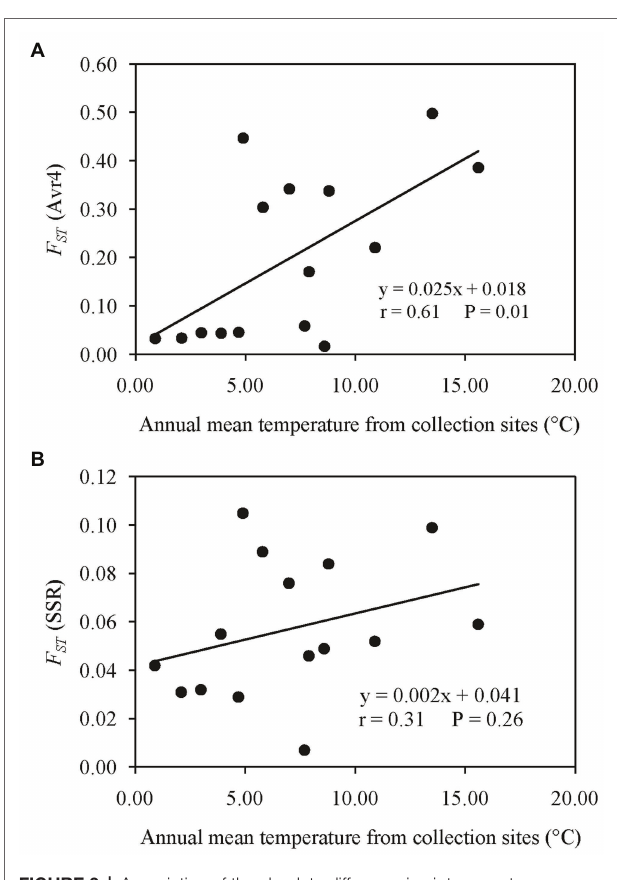
FIGURE 3 | Association of the absolute difference in air temperature between collection sites and the pairwise FST : (A) Avr4 gene and (B) SSR marker